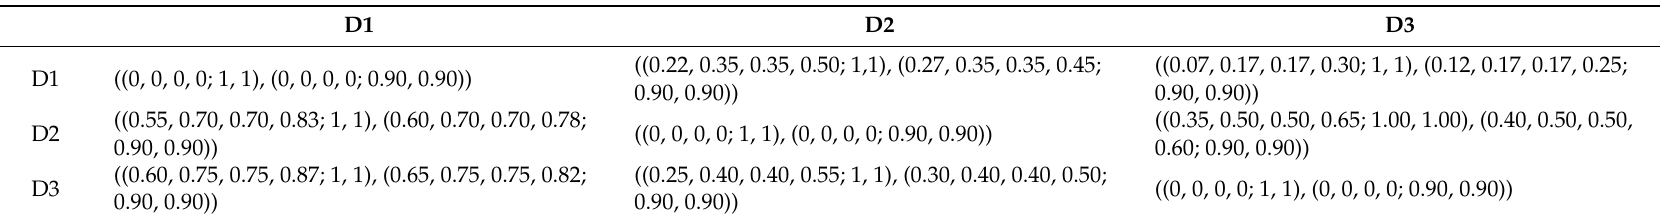
Table A3. Fuzzy direct relation matrix for the dimensions.